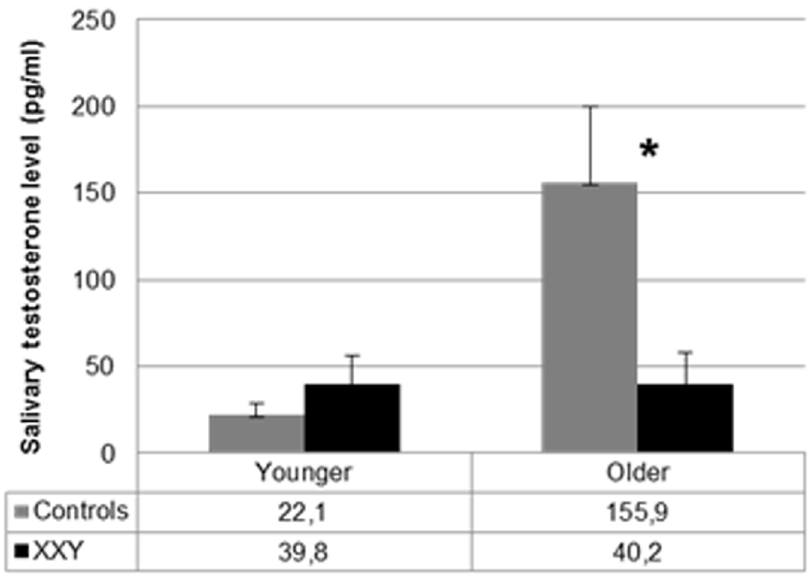
Fig 1. Levels of salivary testosterone (mean, SE) in the XXY group versus controls, stratified for different age groups, i.e. younger boys (8–12 years) and older boys (12–19 years). (cid:3) Significant at p < .05.